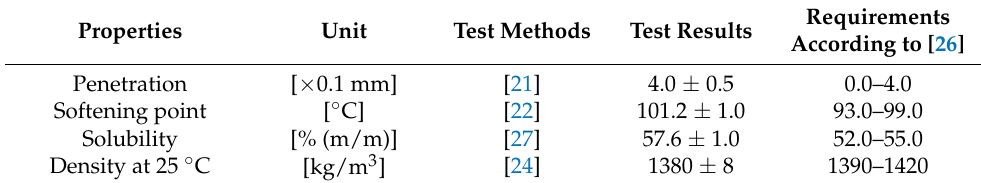
Table 2. Basic properties of Trinidad Lake Asphalt